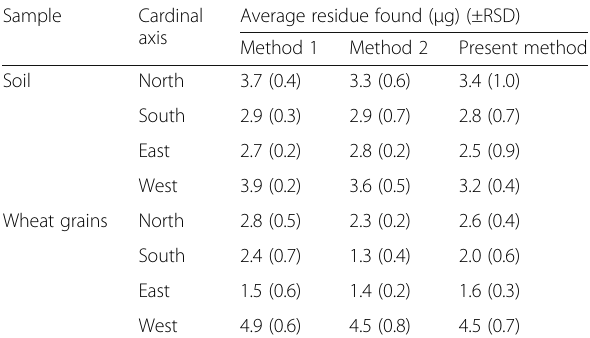
Table 4 Percent recovery of PXD extracted with the modified QuEChERS method